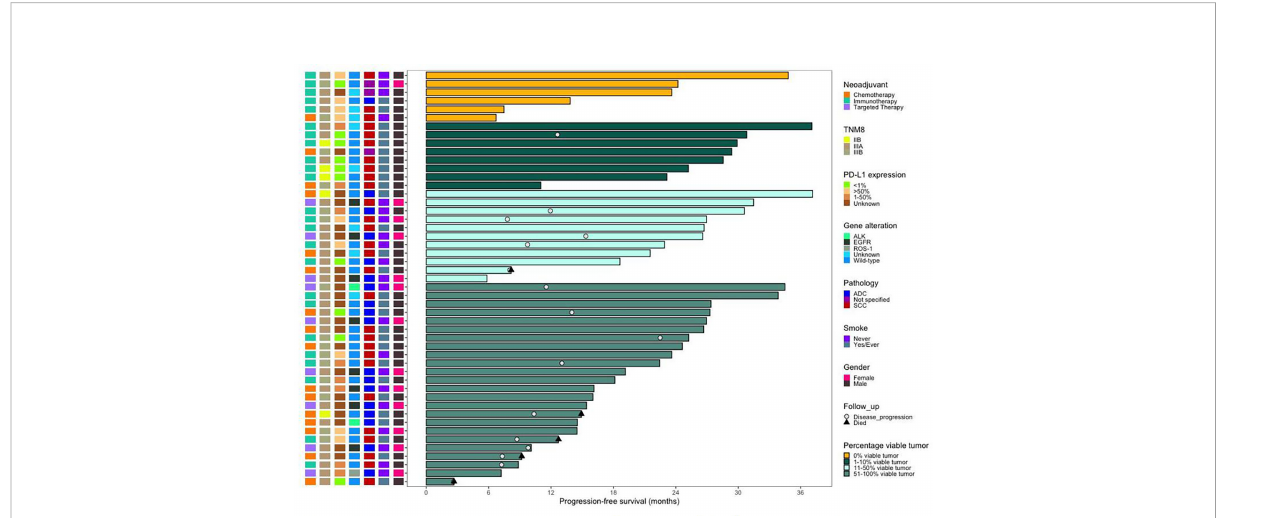
FIGURE 3 Swimming plot of progression-free survival in the patients who underwent surgery. (N = 49). Each bar represents one patient. The left column shows clinical characterestics. Date cutoff was Nov. 4, 2021, sixteen (32.7%) patients who underwent surgery had disease progression, fi ve (10.2%) of whom died. Of the 14 patients with pCR or MPR, one patient who received neoadjuvant immunotheraphy had disease progression. Of the 16 (one patient has died), 5 patient received neoadjuvant immunotheraphy (four patients have died), and 3 patients received neojuvant targeted